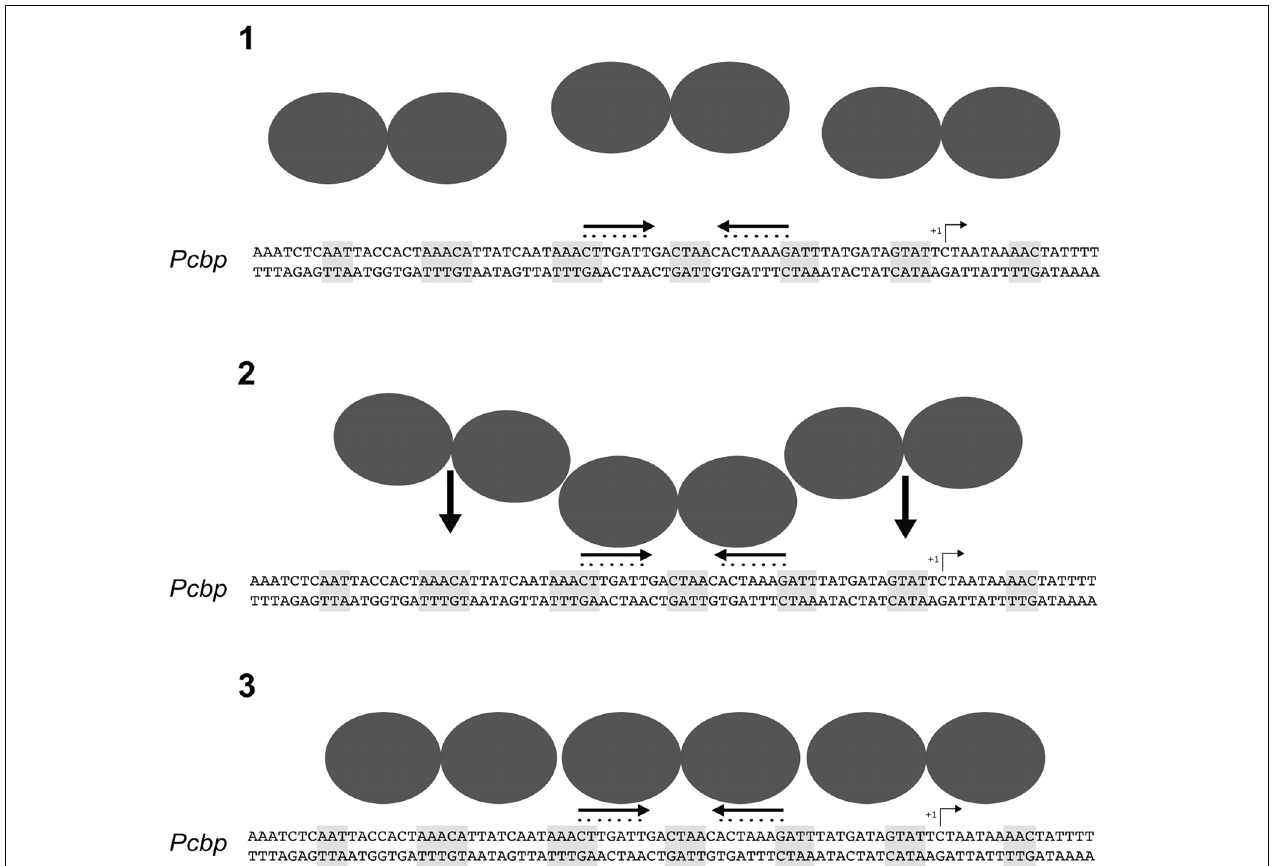
FIGURE 7 | Model of the molecular mechanism for HspR-DNA binding. In solution, HspR dimerizes (1) and binds with high affinity to the DNA region containing the HAIR consensus sequence (2). This binding could act as a nucleation center driving cooperative binding of two HspR dimers on the flanking regions (3), likely recognizing still unknown sequence